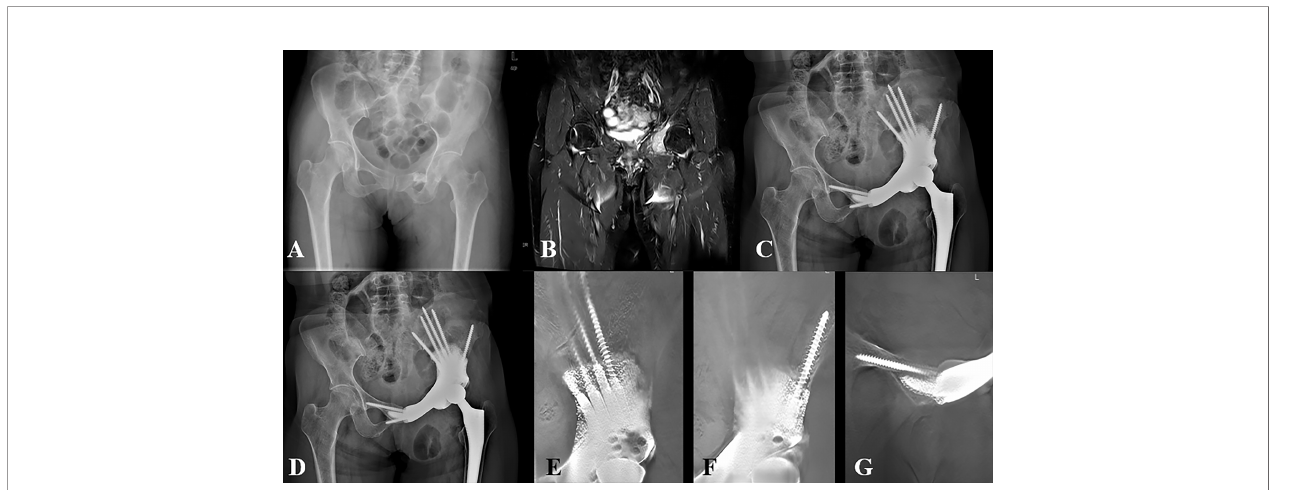
FIGURE 5 | Representative case of the iliofemoral group. (A) Preoperative X-ray of the pelvis of patient 11. (B) Preoperative MRI of the pelvis. (C) X-ray of the pelvis taken at 3 days after surgery. (D) X-ray of the pelvis taken at 30 months after surgery. (E – G) T-SMART taken at 6 months after surgery showed excellent